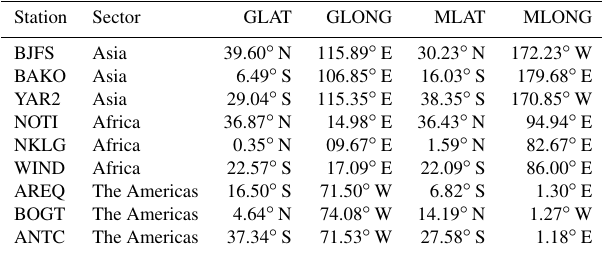
Table 1. Geographic latitude (GLAT), geographic longitude (GLONG), geomagnetic latitude (MLAT) and geomagnetic longi- tude (MLONG) of the GPS stations located in different regions used in the